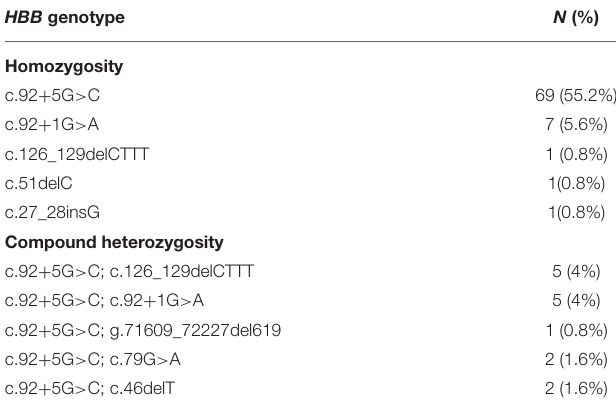
TABLE 1 | The HBB genotype distribution and their